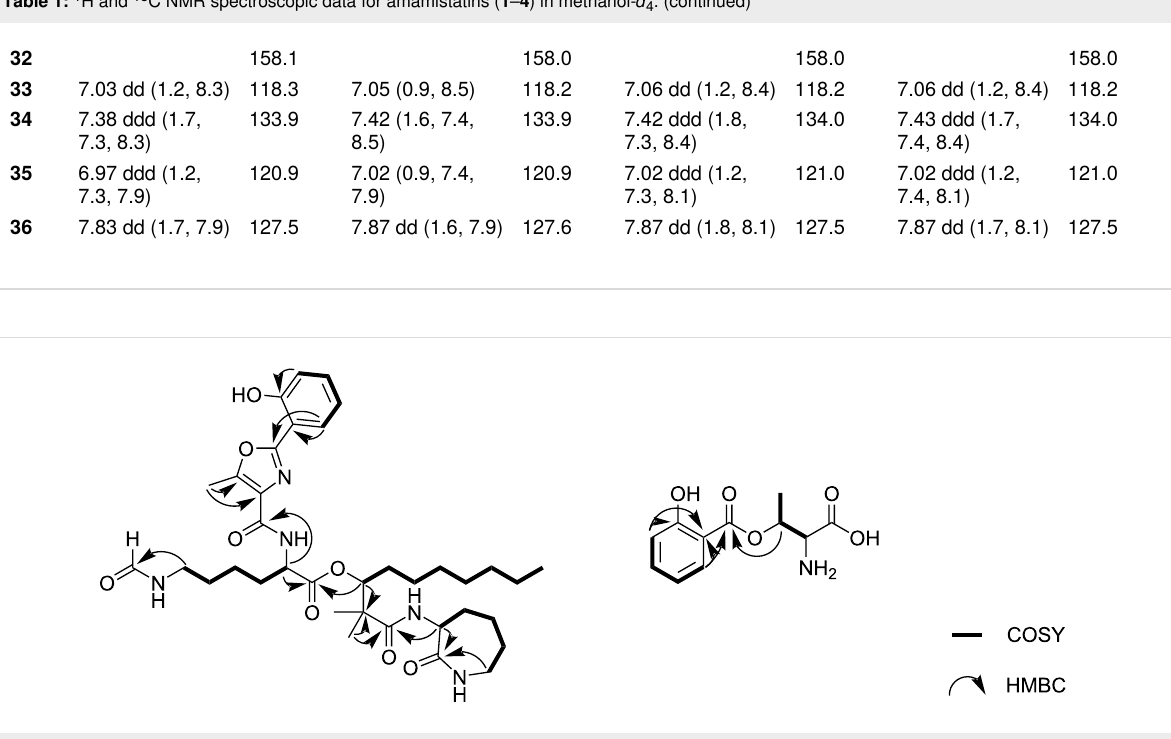
Table 1: 1 H and 13 C NMR spectroscopic data for amamistatins ( 1 – 4 ) in methanol- d 4 . (continued)